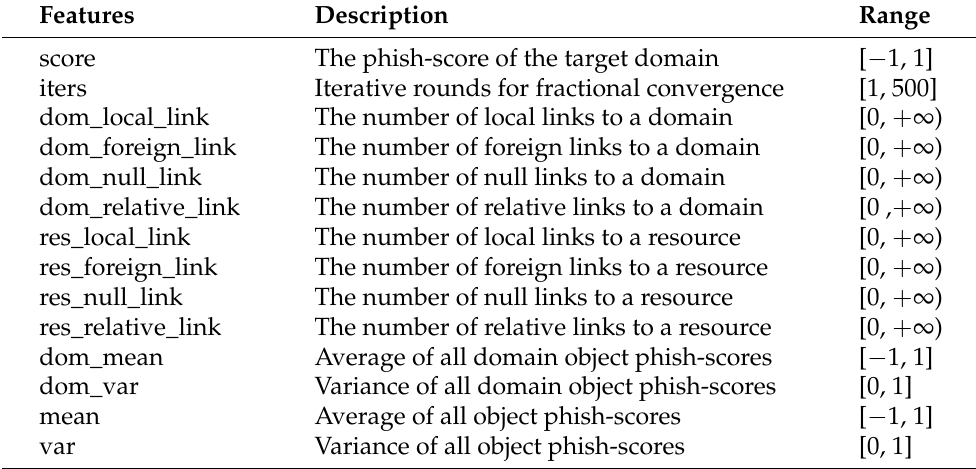
Table 2. Features and descriptions.